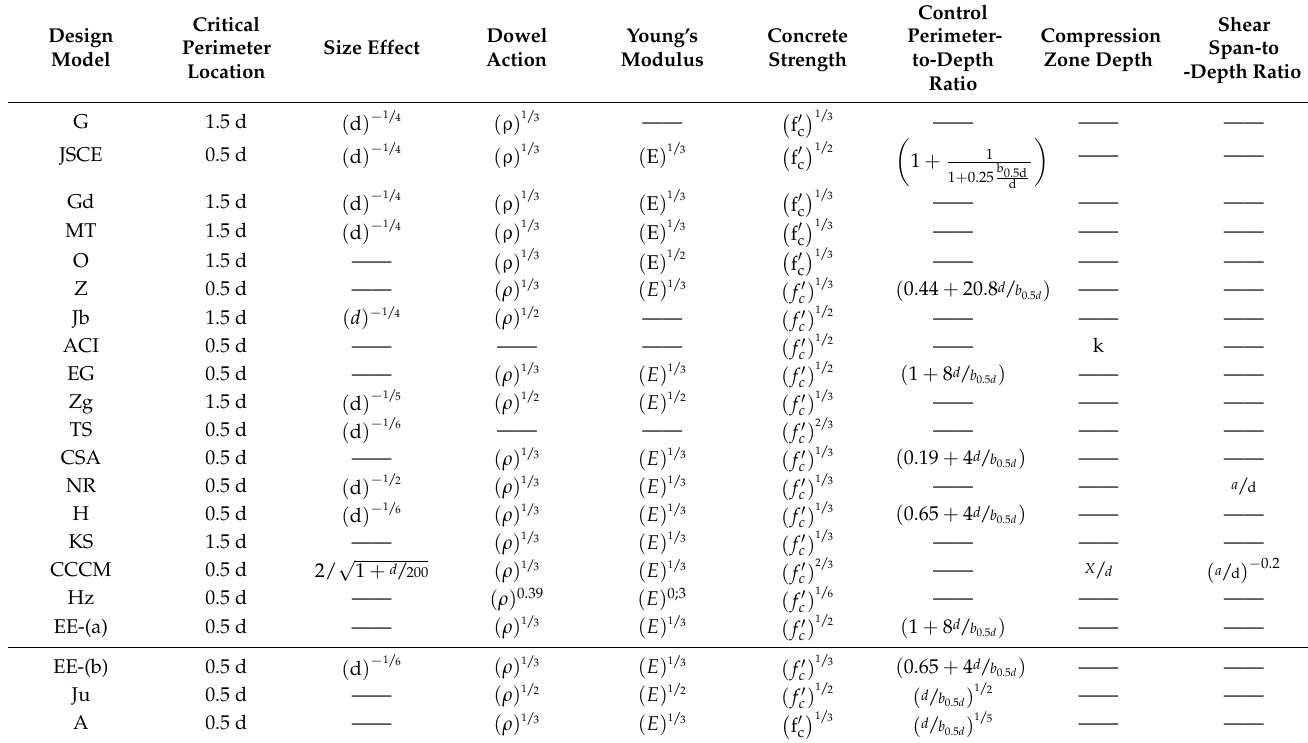
Table 1. Comparison between design